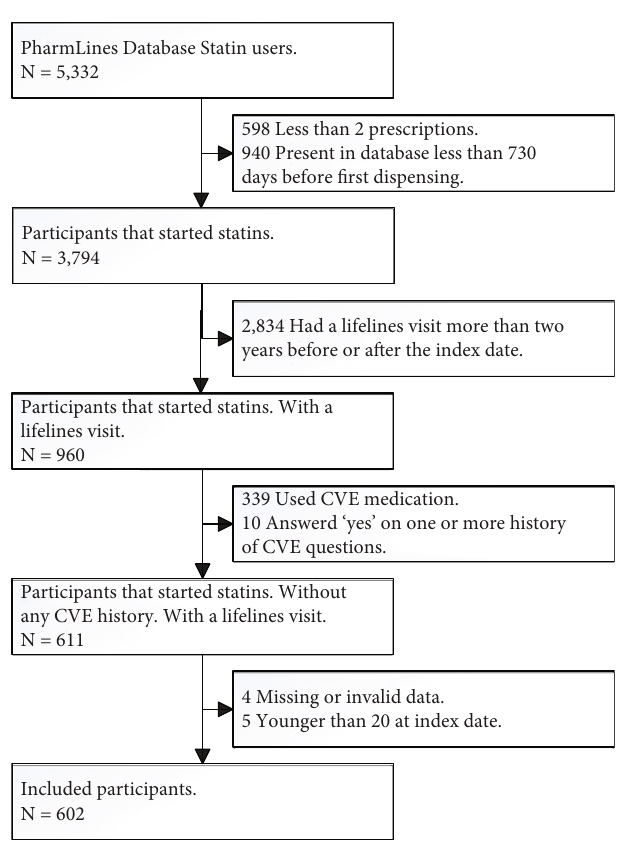
Figure 1: Scheme of exclusion route. Abbreviations: CVE: cardiovascular